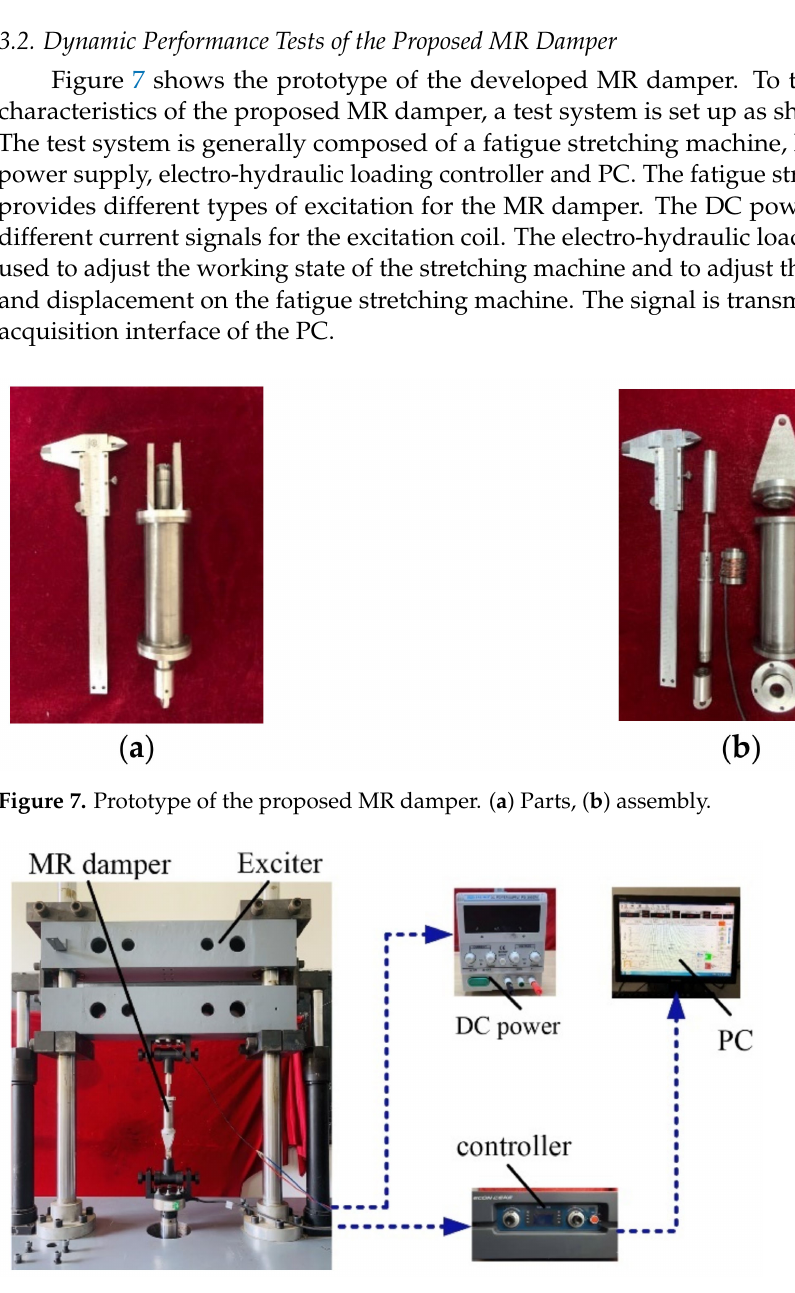
Figure 8. Performance test system for the proposed MR